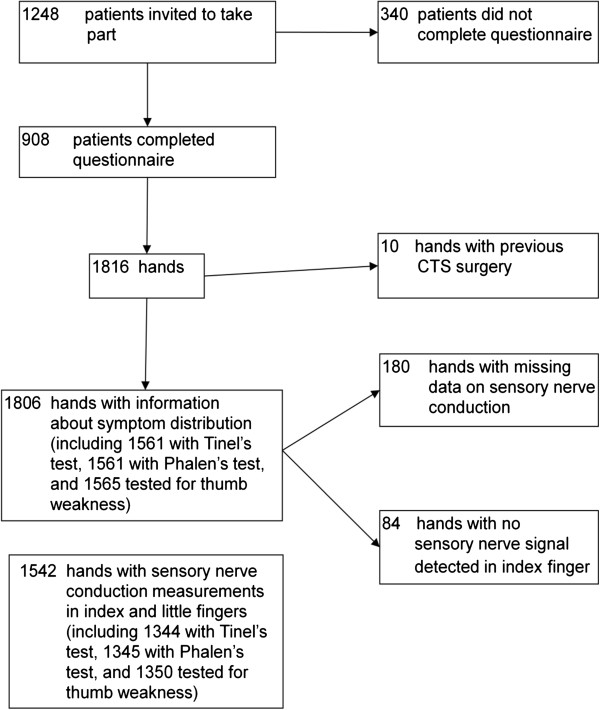
Recruitment of patients and numbers of hands analysed.